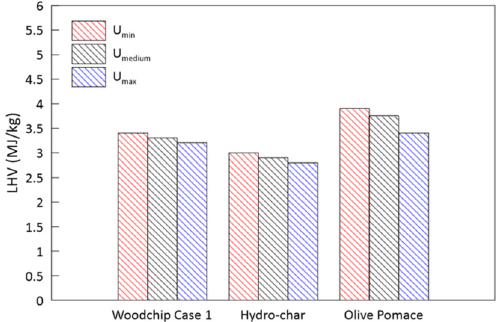
Figure 20. Syngas LHV (on a daf basis) at different biomass/residual material initial moisture content levels for woodchip case 1, hydro-char from green waste, olive